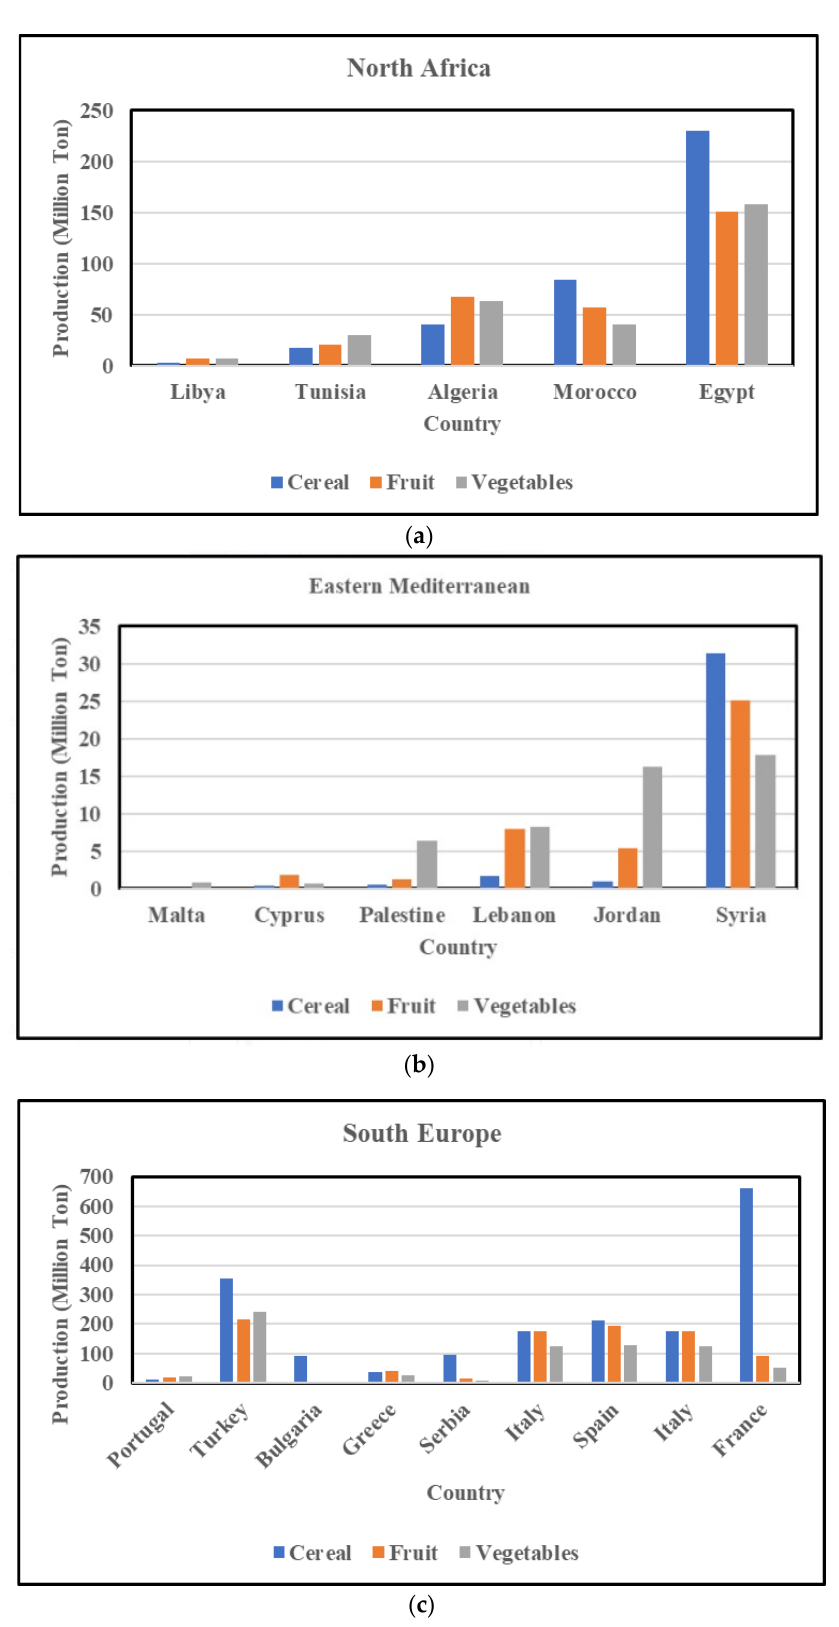
Figure 5. Crop production in ( a ) North Africa, ( b ) East Mediterranean, and ( c ) South Europe. Data source: World Bank.